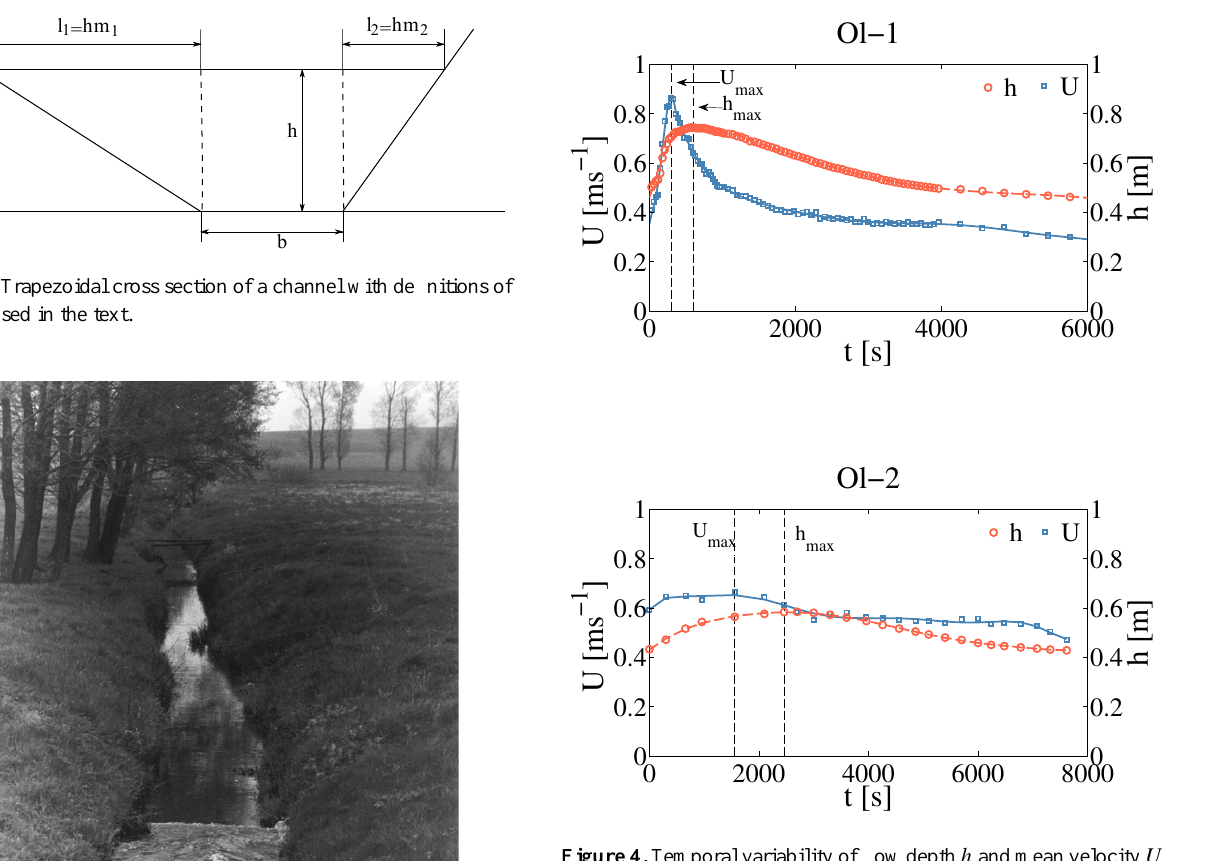
Figure 4. Temporal variability of flow depth h and mean velocity U for experimental flood waves in the Olszanka